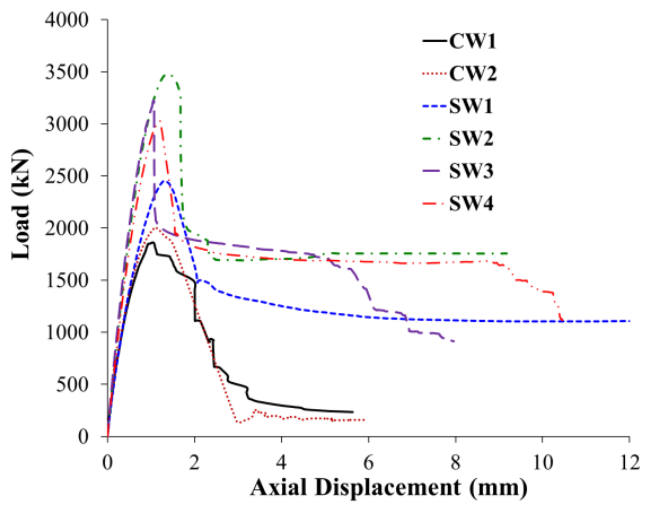
Figure 11. Experimental load versus axial displacement plots for tested columns.